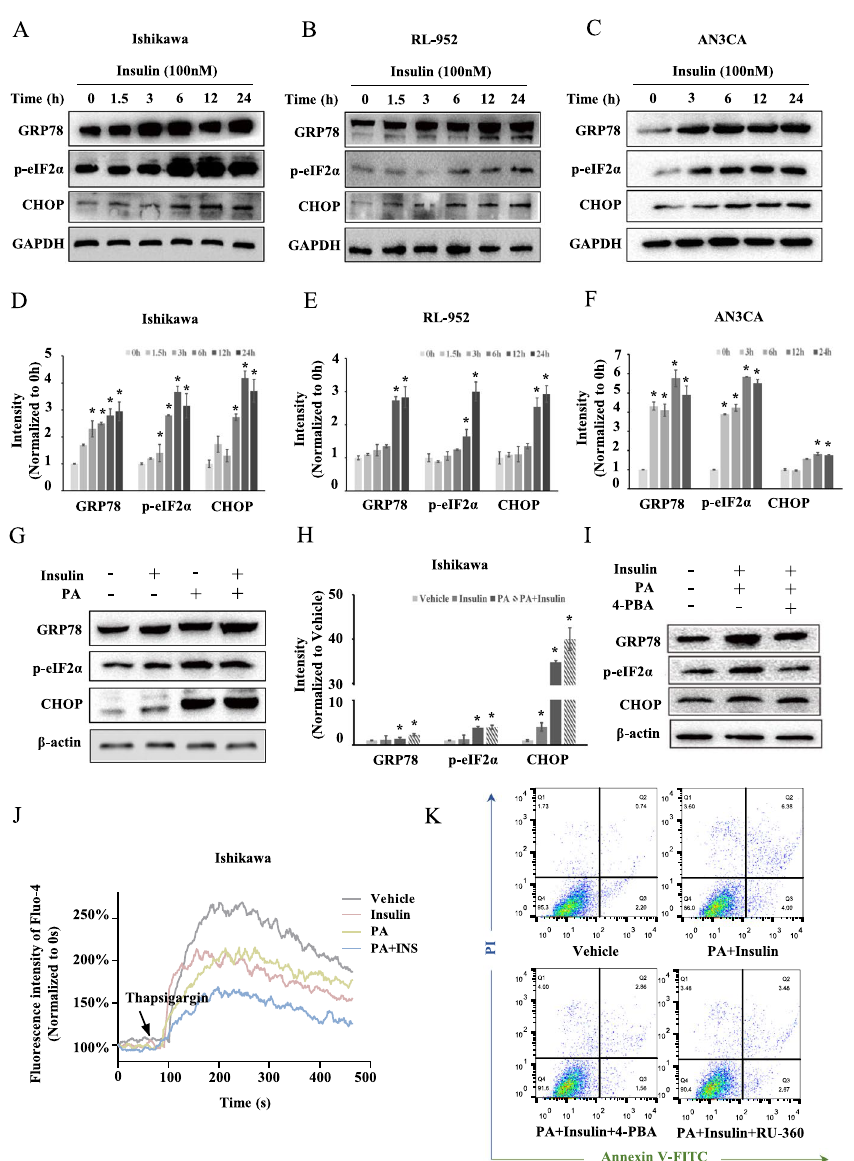
Fig. 4 Endoplasmic reticulum stress and Ca 2 + homoeostasis are essential for promoting apoptosis by combined effect of insulin and palmitic acid. A – C Immunoblot of ER stress marker GRP78, p-eIF2α and CHOP after treating with 100 nM insulin for 0–24 h in Ishikawa, RL-952 and AN3CA cells. D – F Histogram plot shows change of ER stress marker with insulin treatment in EC cells relative to 0 h. * P < 0.05. G , H Immunoblot of ER stress marker GRP78, p-eIF2α and CHOP after treating with insulin, PA and insulin plus PA. Histogram plot shows change of ER stress marker with insulin and/or PA treatment * P < 0.05. I Immunoblot of GRP78, p-eIF2α and CHOP after PA plus insulin treatment with or without 4-phenylbutyric acid (4-PBA) pre-treatment. J Ca 2 + store in endoplasmic reticulum after treatment with vehicle, 100 nM insulin alone, 0.5 mM PA alone or 0.5 mM PA plus 100 nM insulin for 6 h. K Apoptosis of Ishikawa cells detecting by Annexin V-FITC/PI labelling flow cytometry after 0.5 mM PA plus 100 nM insulin treatment for 12 h, with or without pretreatment with 4-phenylbutyric acid (4-PBA) or